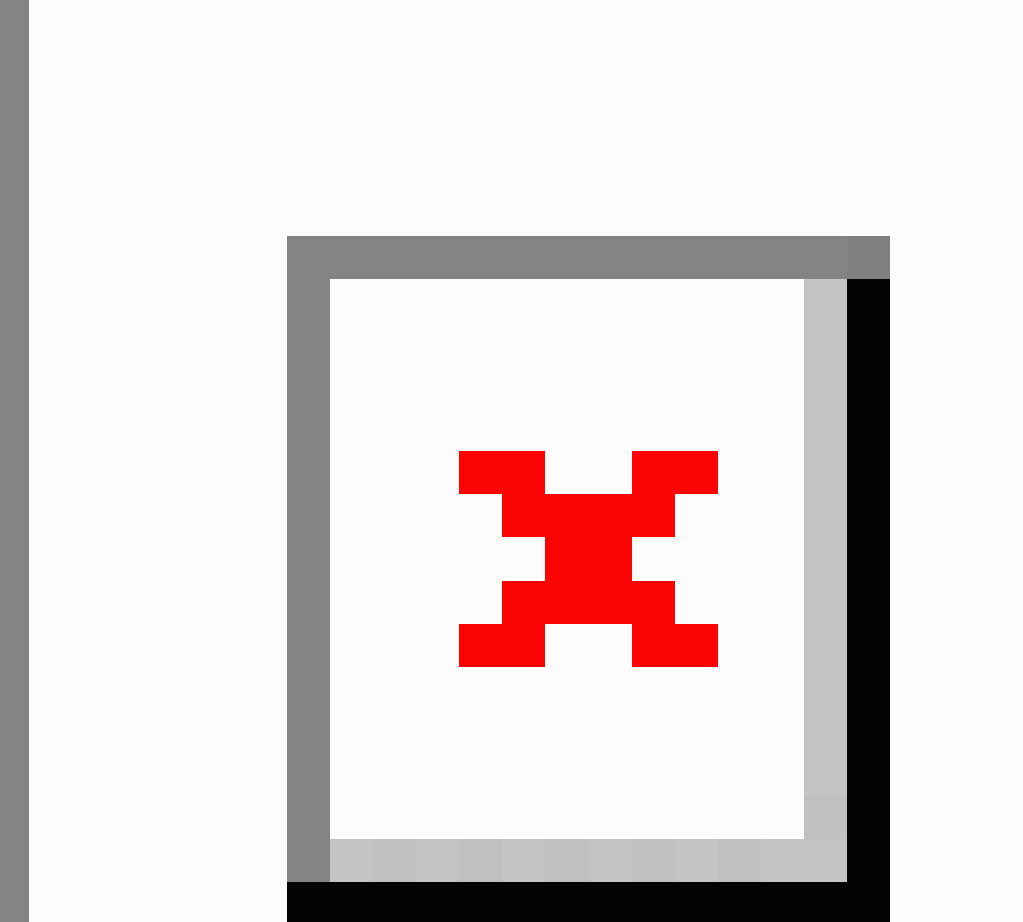
Figure 1. The number of new SmokeFree.gov website visitors from January to April 2019 and 2020. The vertical line represents January 20. On this day in 2020, the first laboratory-confirmed COVID-19 case was identified in the United States. This was reported to the Centers for Disease Control and Prevention on January 22, 2020 [43]. Data on model selection appear in Multimedia Appendix 1. DPC: daily percent change. *The DPC is significantly different from 0 at an α level of